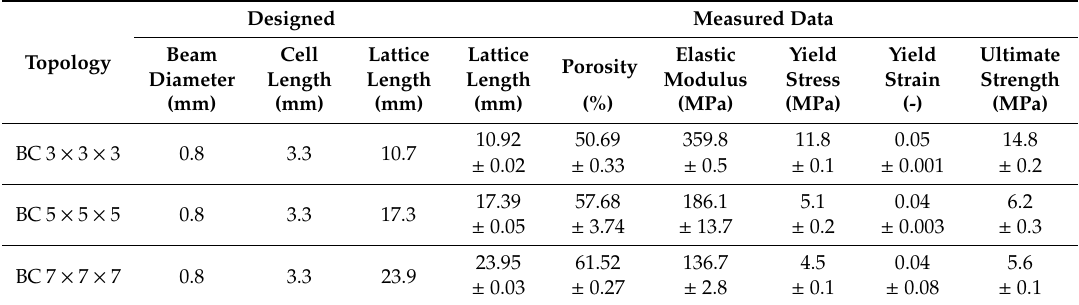
Table 2. Design and measurements for rescaled lattices.